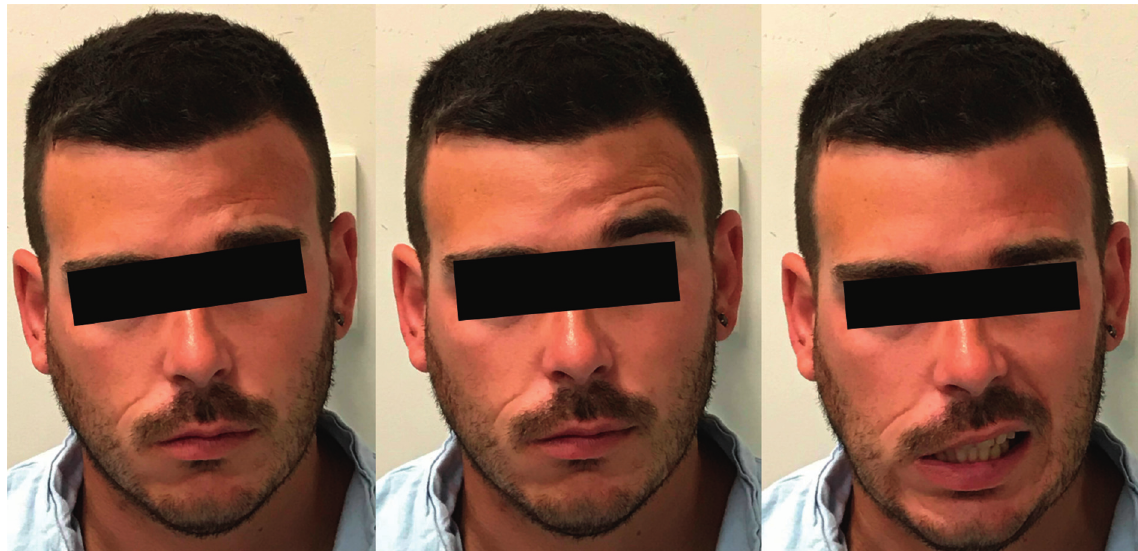
Figure 2: Peripheral FN palsy evaluated as HB grade 4 upon